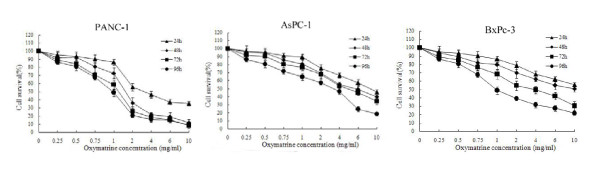
The inhibitory effect of oxymatrine on the growth of PANC-1, BxPc-3 and AsPC-1cells. The inhibitory effects of oxymatrine on the growth of PANC-1, BxPc-3 and AsPC-1 cells were observed in both a dose- and time-dependent manner. PANC-1, BxPc-3 and AsPC-1 cells treated with different concentrations of oxymatrine (0.25, 0.5, 1, 2, 4, 6 and 10 mg/mL) and the cell survival rates were calculated for different periods of time (24, 48, 72 and 96 h).